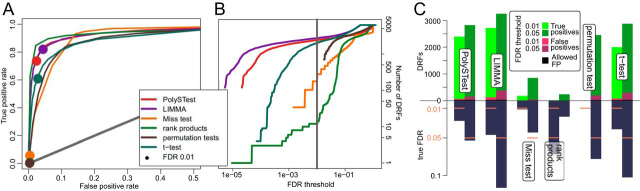
PolySTest provides a high number of true positives at typical confidence levels for the 3-species data set.A, ROC curve comparing the different statistical tests with filled circles indicating an FDR of 0.01. Rank products seems to perform best but produces only a very low number of DRFs (B). C, Comparison of test performance on basis of sensitivity and confidence for FDR thresholds of 1 and 5%.